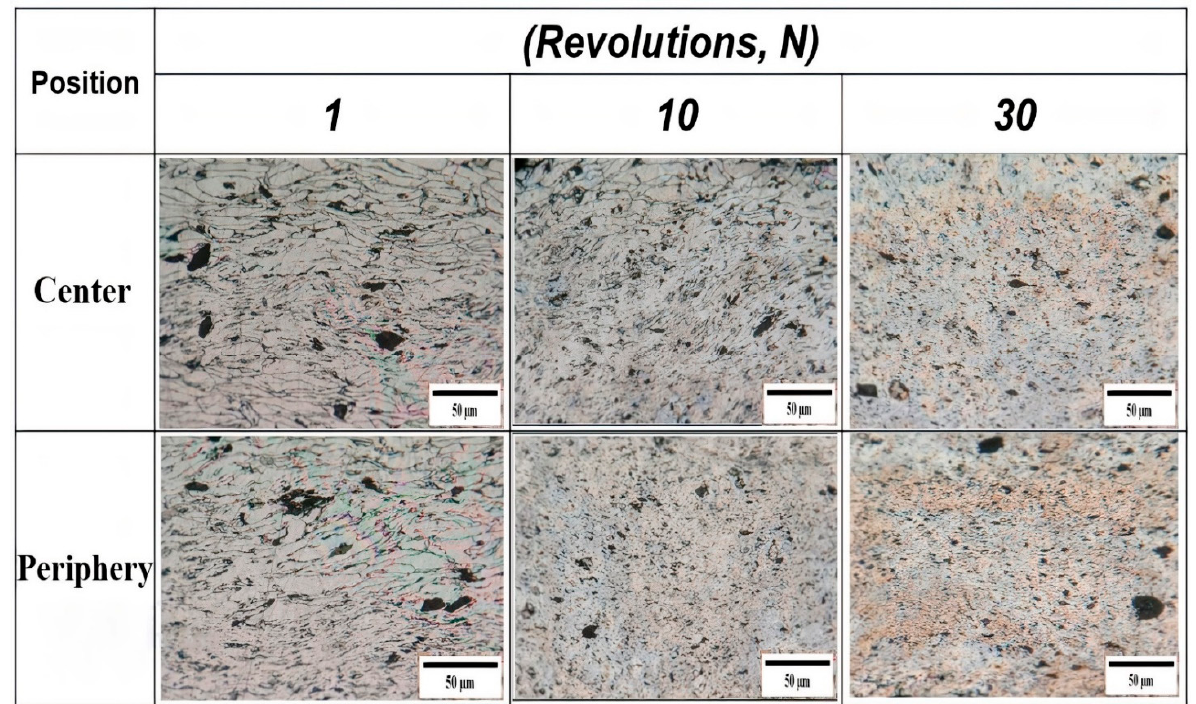
Figure 4. Microstructural evolution of HPT processed samples under a pressure of 5 GPa. Images taken from a diametral cross section of the disks.